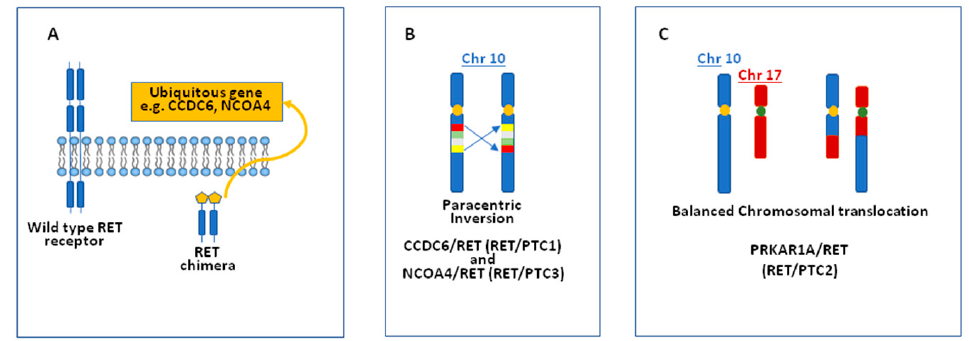
Figure 2. Mechanisms of RET/papillary thyroid carcinoma (PTC) activation. ( A ): the tyrosine kinase domain of the RET gene is constitutively activated by the fusion with a ubiquitous gene; ( B ): a paracentric inversion on chromosome 10 leads to the formation of a RET chimera as RET/PTC1 and RET/PTC3; ( C ): a chromosomal translocation leads to the formation of a RET chimera as RET/PTC2.